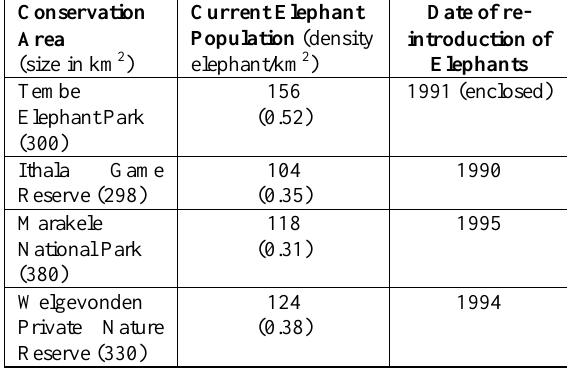
Four study areas with elephant populations and